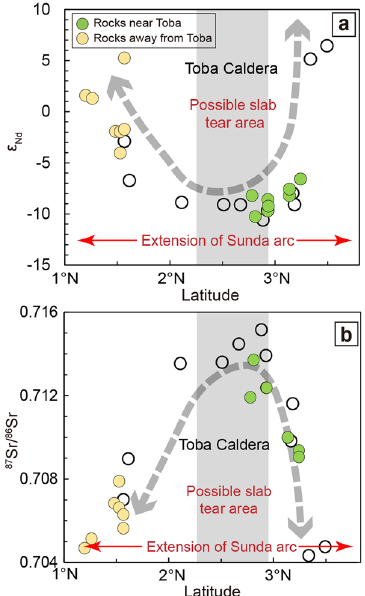
Fig. 4 Latitudinal (Along-arc) isotopic variations of Sunda arc volcanic rocks in northern Sumatra. a Variations of ε Nd values with latitudes showing that arc volcanic rocks on Sumatra display decreasing ε Nd values towards the Toba Caldera. b Similar with a , but for 87 Sr/ 86 Sr values. Open circles represent data from refs. 17,39 (Supplementary Data 4). COMMUNICATIONS EARTH & ENVIRONMENT| (2022) 3:283